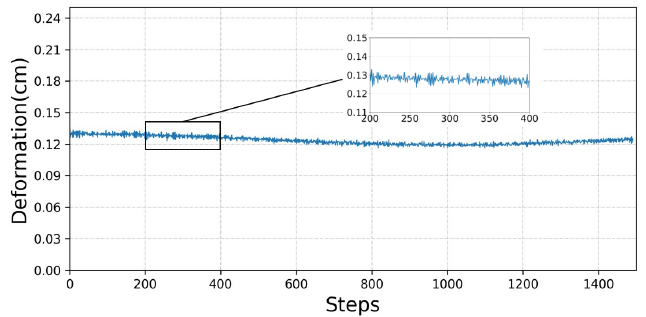
Figure 7. Deformation size of contact